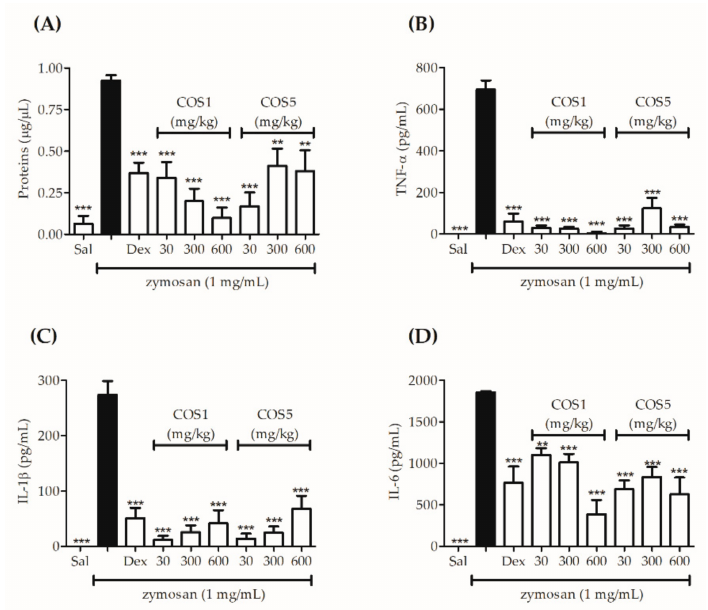
Figure 8. Effects of COS1 and COS5 in the air pouch model at 30, 300, and 600 mg/kg doses on the quantification of total proteins ( A ) and levels of cytokine pro-inflammatory TNF- α ( B ), IL-1 β ( C ), and IL-6 ( D ) estimated using ELISA. Note: *** p < 0.001 and ** p < 0.01 compared to the zymosan group (black column). Sal: saline solution (0.9 mg/mL); Dex: dexamethasone (2